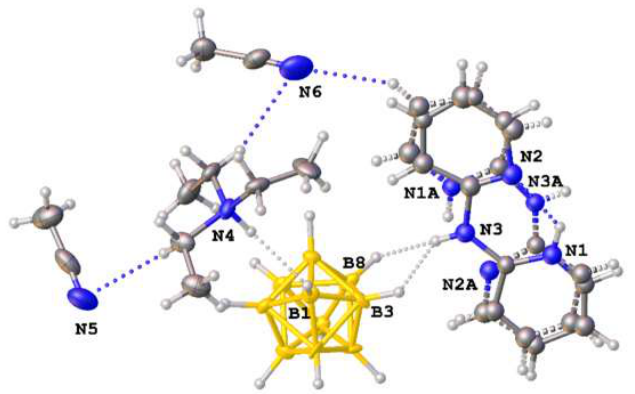
Figure 3. Asymmetric unit of 3 · 2CH 3 CN in representation of atoms with thermal ellipsoids (p = 50%). H-bonds are depicted with dotted lines.